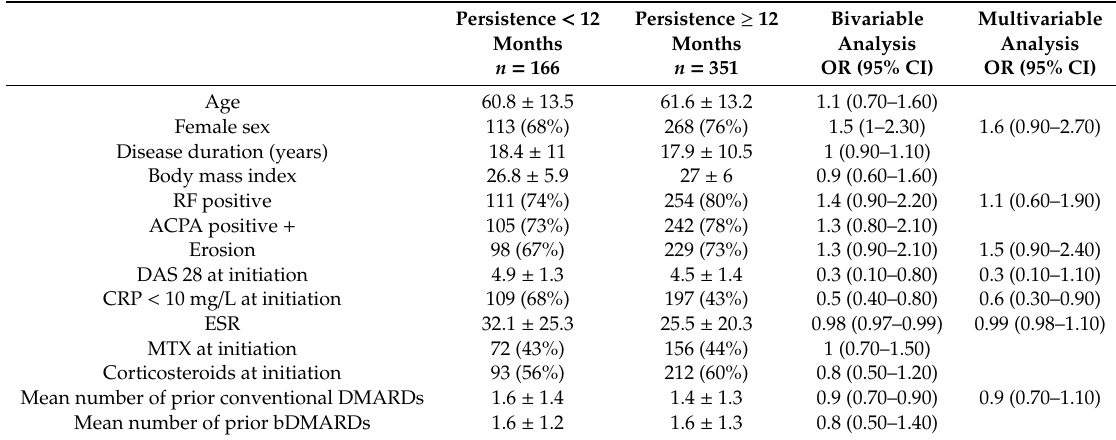
Table 2. Factors associated with drug persistence at 12